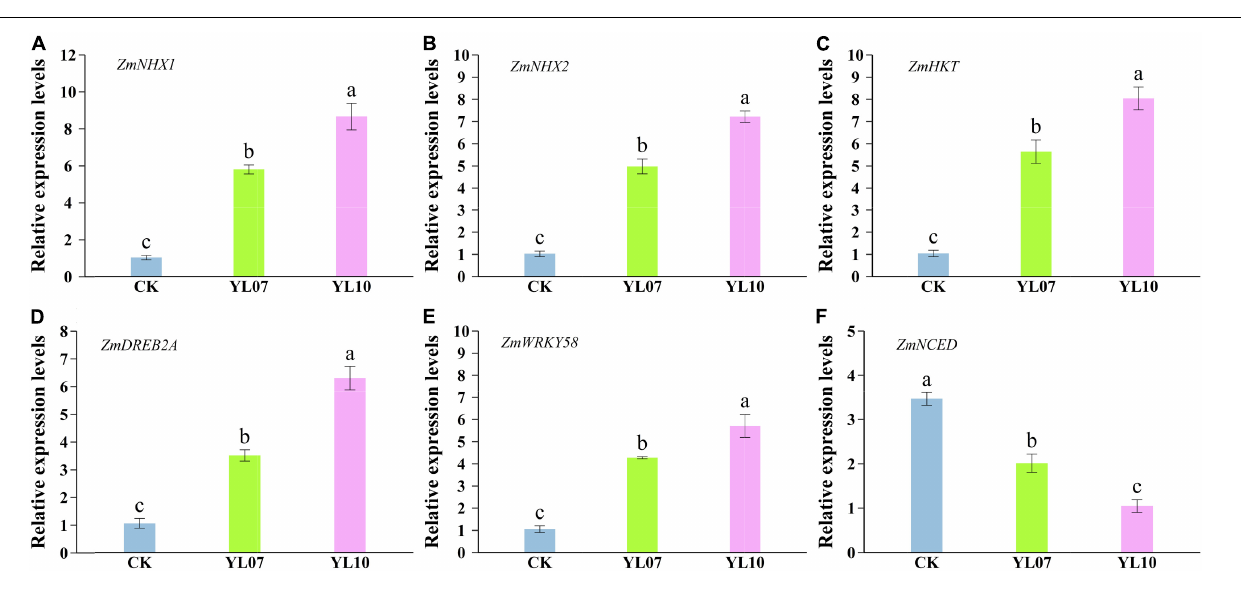
FIGURE 4 | Effect of inoculating with strains YL07 and YL10 on the expression of genes including ZmNHX1 (A) , ZmNHX2 (B) , ZmHKT (C) , ZmDREB2A (D) , ZmWRKY58 (E) , and ZmNCED (F) related to salt tolerance in maize seedlings under NaCl stress conditions. Different letters indicate significant differences at the P < 0.05 level among the different treatments, as determined by LSD post hoc comparison